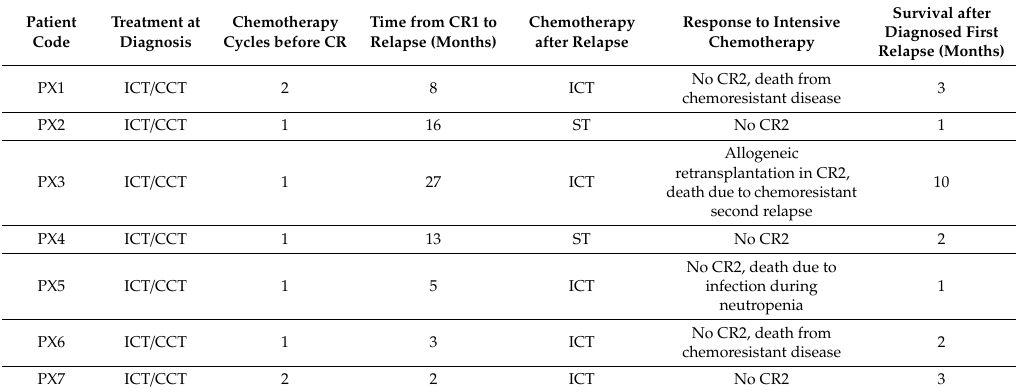
Figure 1. Overview of the matched diagnosis–first relapse patient cohort. The study included paired acute myeloid leukemia (AML) cell samples from seven patients, collected at the times of first diagnosis (DIAGNOSIS) and first relapse (FIRST RELAPSE). All patients received intensive induction chemotherapy and consolidation therapy and achieved complete remission (CR) (Table 1). All relapses occurred within three years after CR. Table 1. Clinical progression of AML patients from the time of first diagnosis until